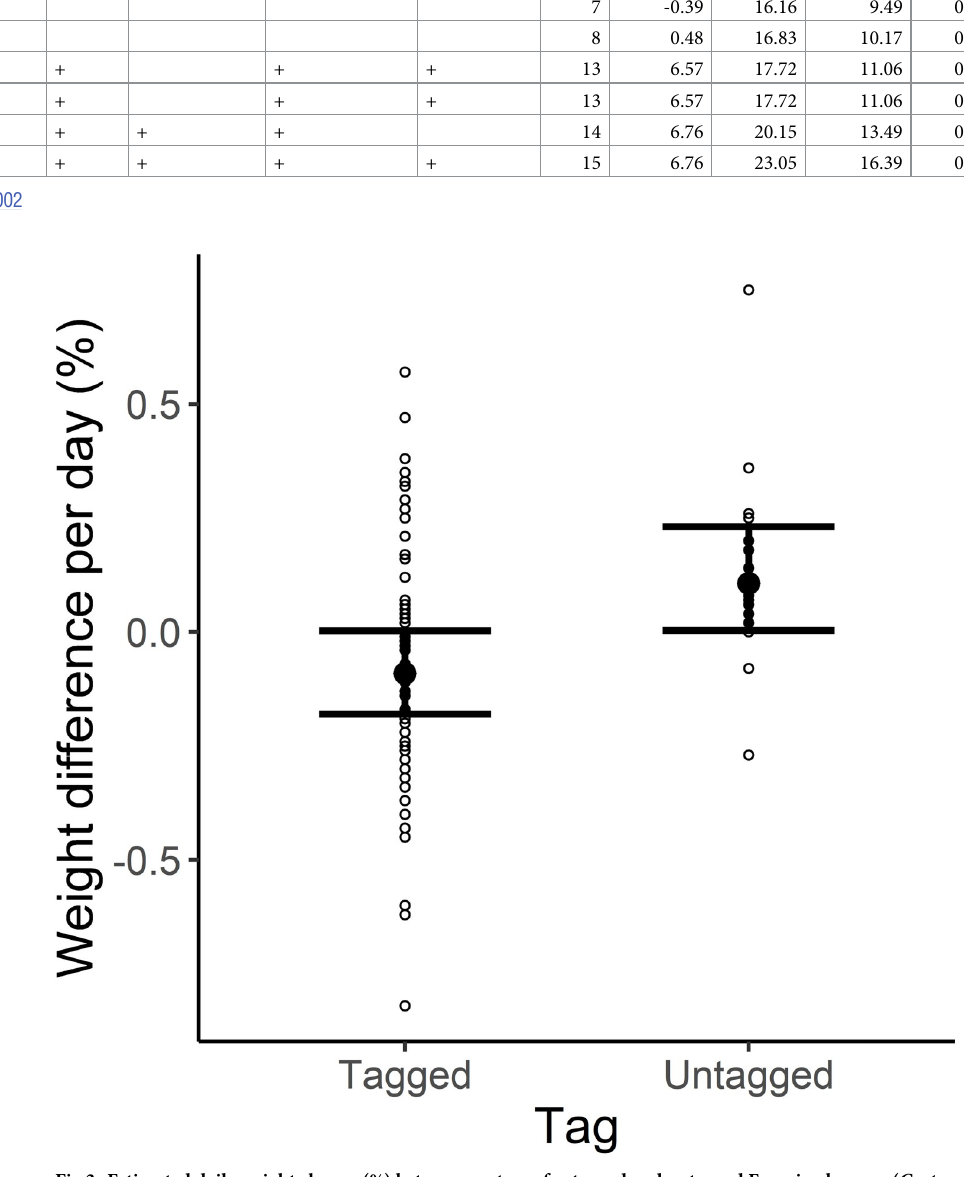
Fig 3. Estimated daily weight change (%) between captures for tagged and untagged Eurasian beavers ( Castor fiber ) in southeastern Norway (2006–2020). The prediction is based on a linear mixed effects model using percent daily body weight change as the response variable. The horizontal lines represent the 95% confidence intervals around each